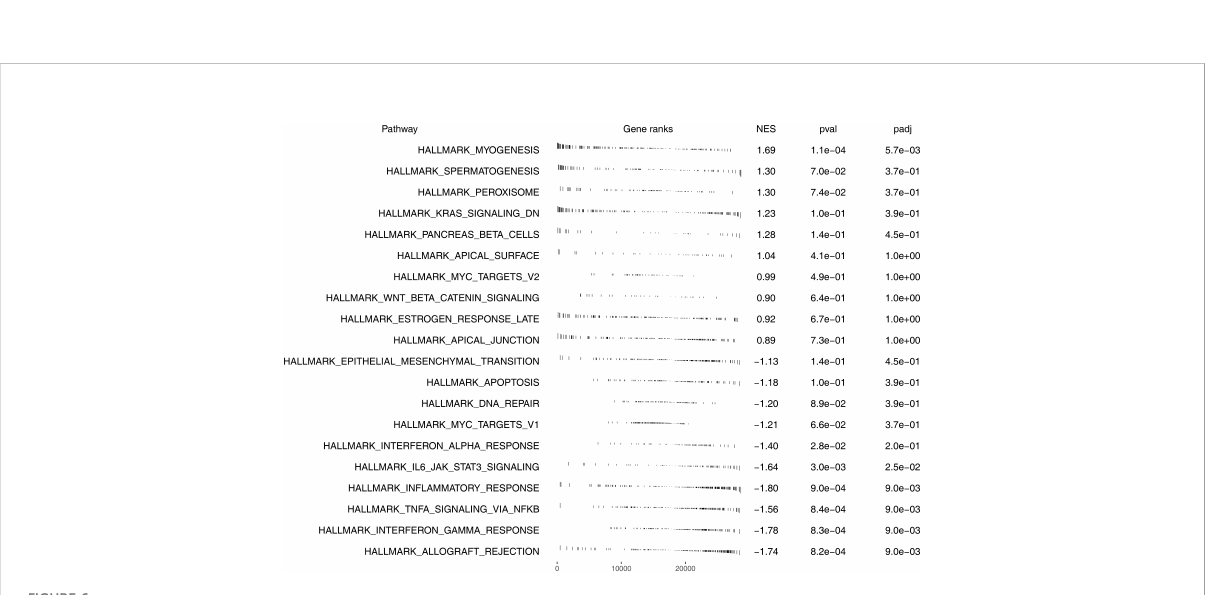
FIGURE 6 Pathway enrichment analysis of our model based on Hallmark gene set.